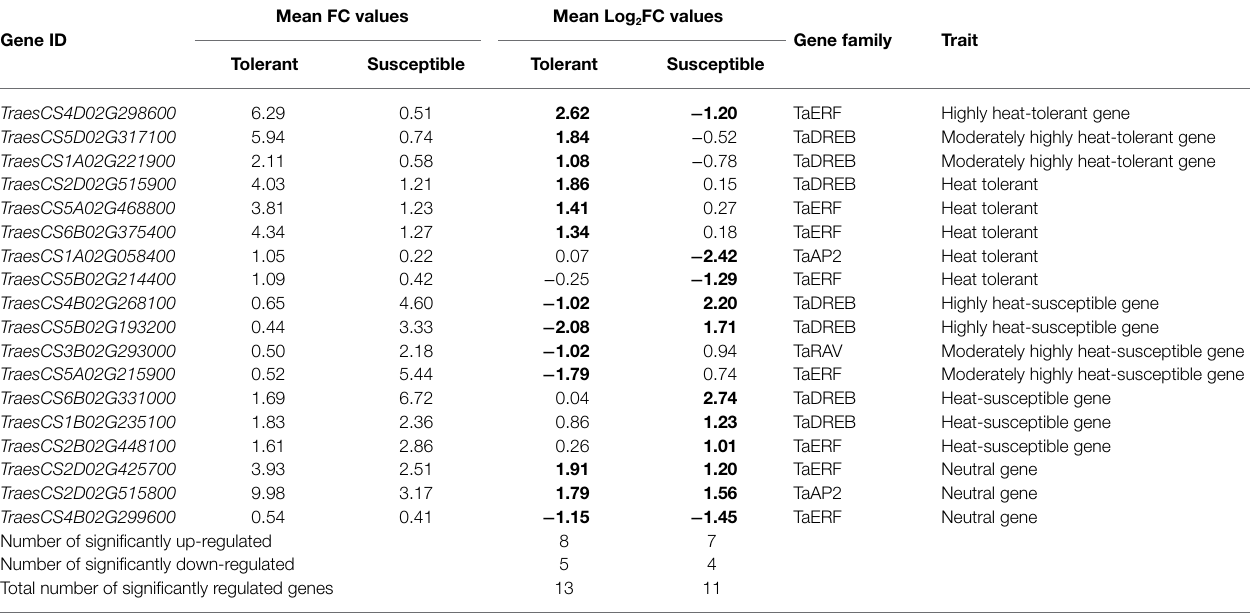
TABLE 1 | Gene expression pattern of candidate TaAP2/ERF genes in tolerant and susceptible genotypes after 3 days heat treatment at 35 ± 1 ° C, normalized with β -actin as standard and control at 25 ± 1 ° C, along with their associated gene family and traits.